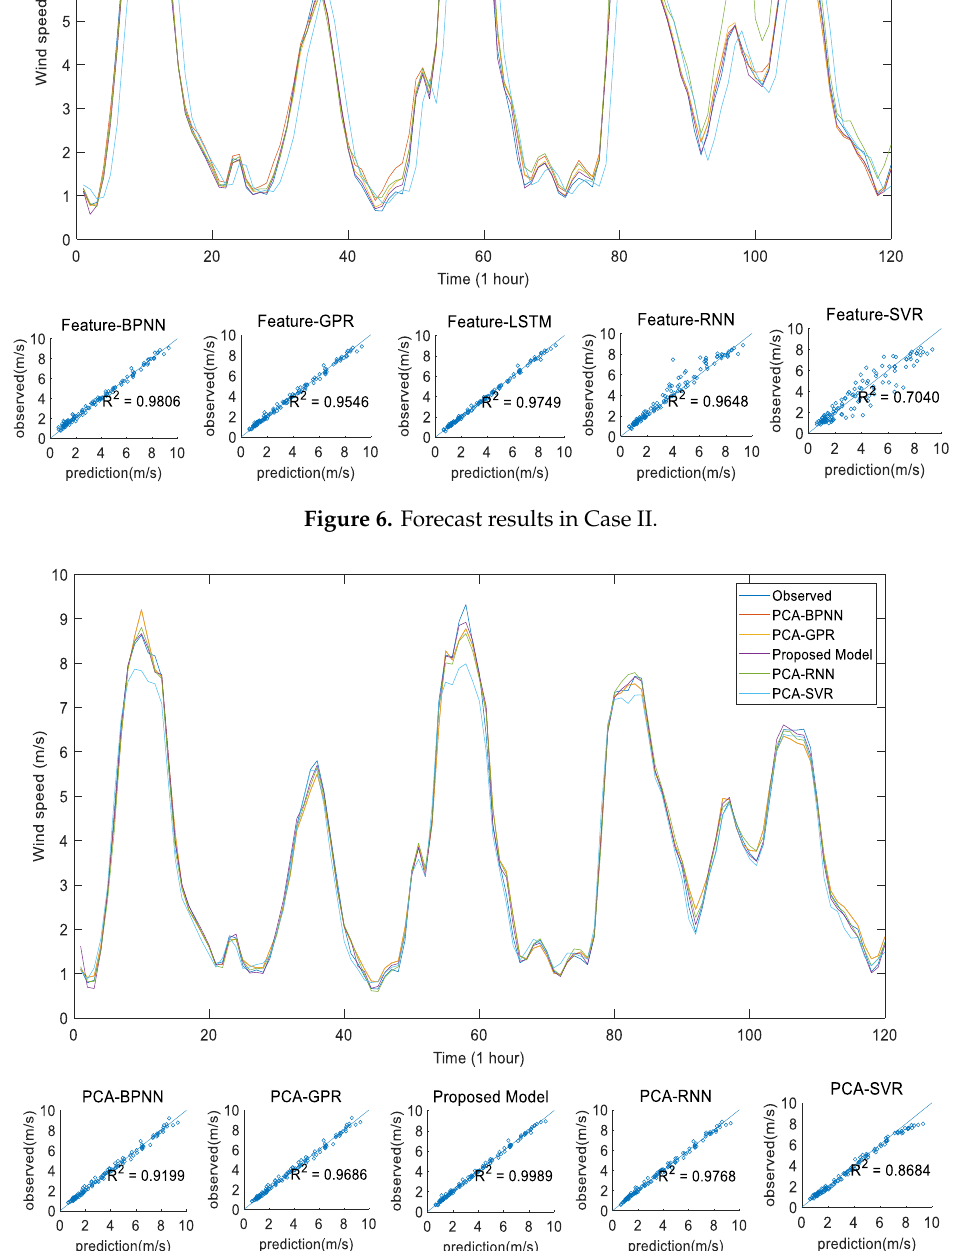
Figure 7. Forecast results in Case III. Table 6. Evaluation index of prediction results.